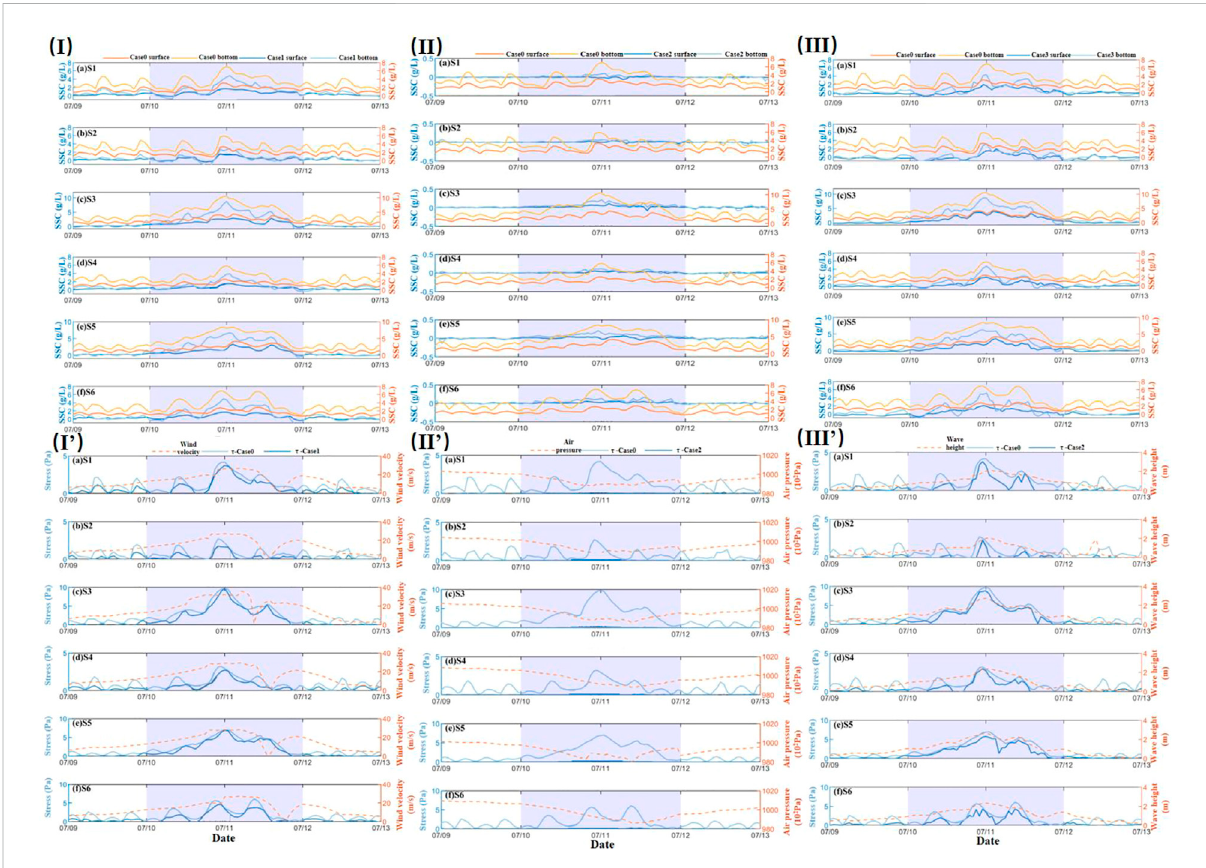
FIGURE 12 (I-I 9 ) ComparisonofSSCandbottomstresscurves ofCases0and1(July9 – 13,2015). (II-II 9 ,III-III 9 ) Thesameas (I-I 9 ) ,but forCases 0and2,and 0 and 3,